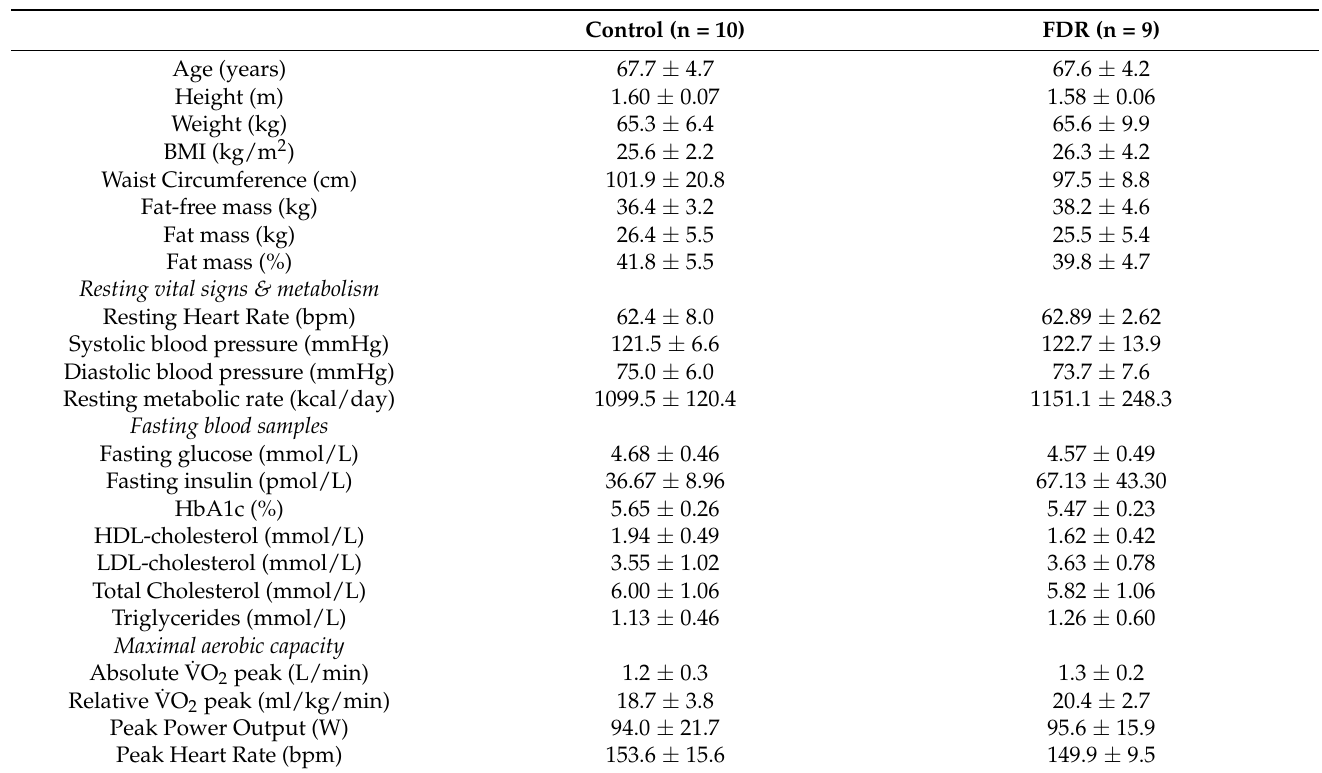
Table 1. Descriptive